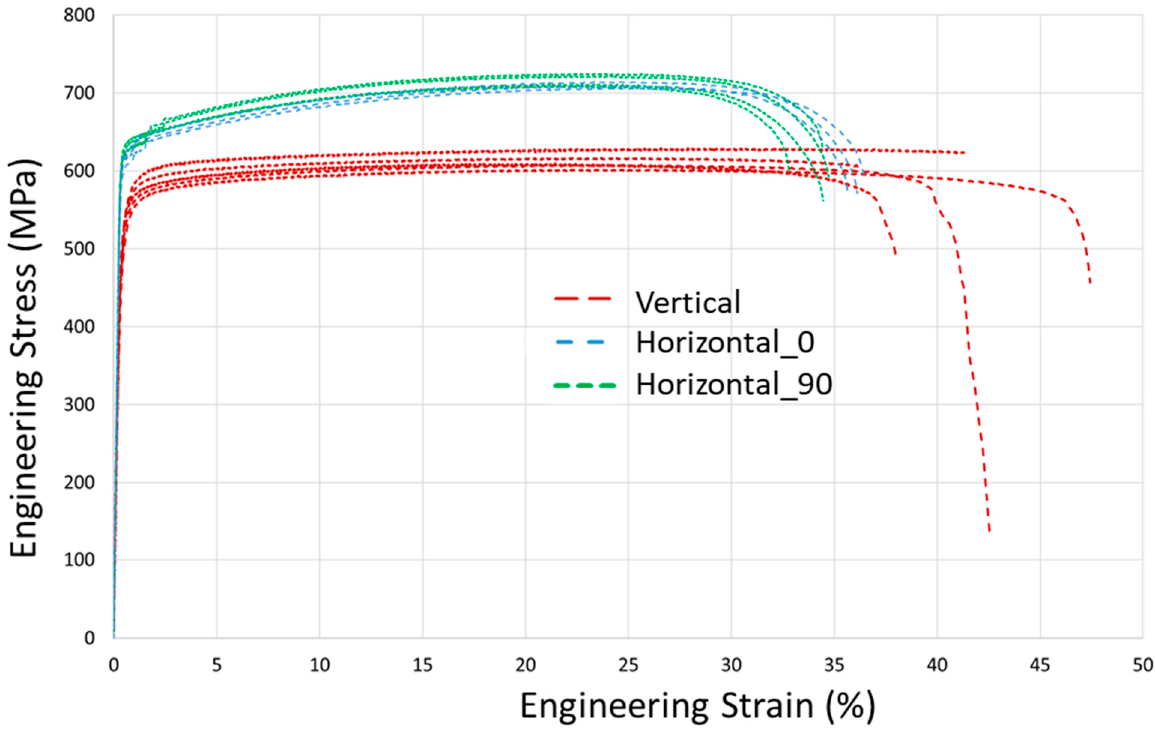
Figure 3. Tensile test results of LPBF processed as-build 316L samples.